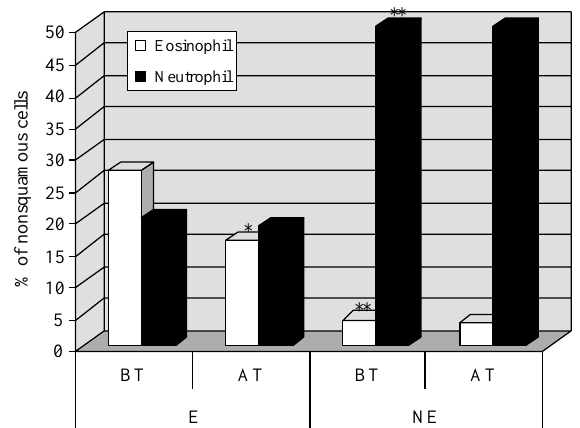
FIG. 2. Induced sputum eosinophil and neutrophil percen- tages, comparison of before treatment (BT) and after treat- ment (AT) levels in eosinophilic (E) and non-eosinophilic (NE) subjects. *p B / 0.05 before versus after treatment, **p B / 0.05 eosinophilic versus